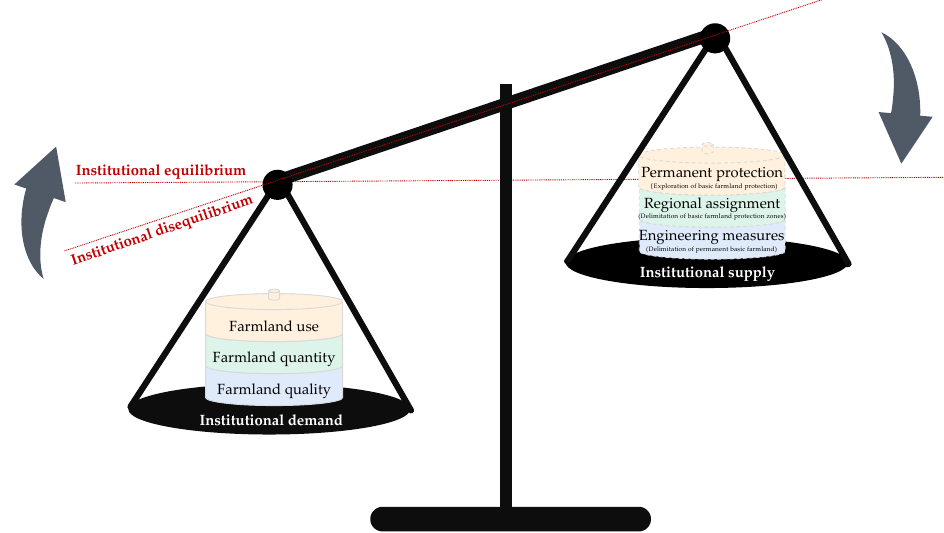
Figure 1. A “scale” model of the evolution of the basic farmland protection system.